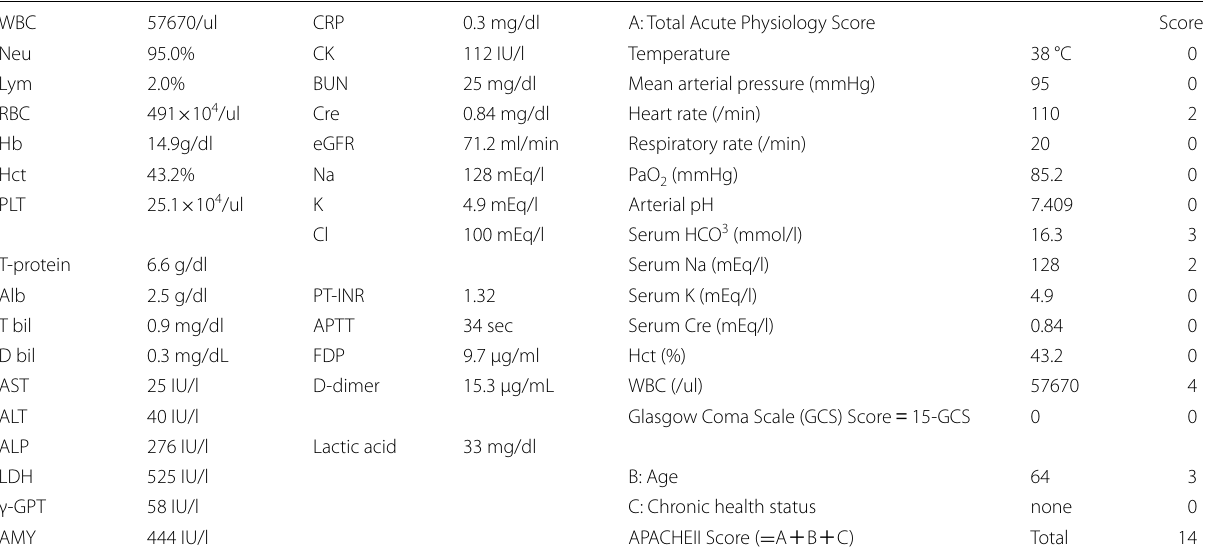
Table 1 Blood test findings and Physiology score (10th day after